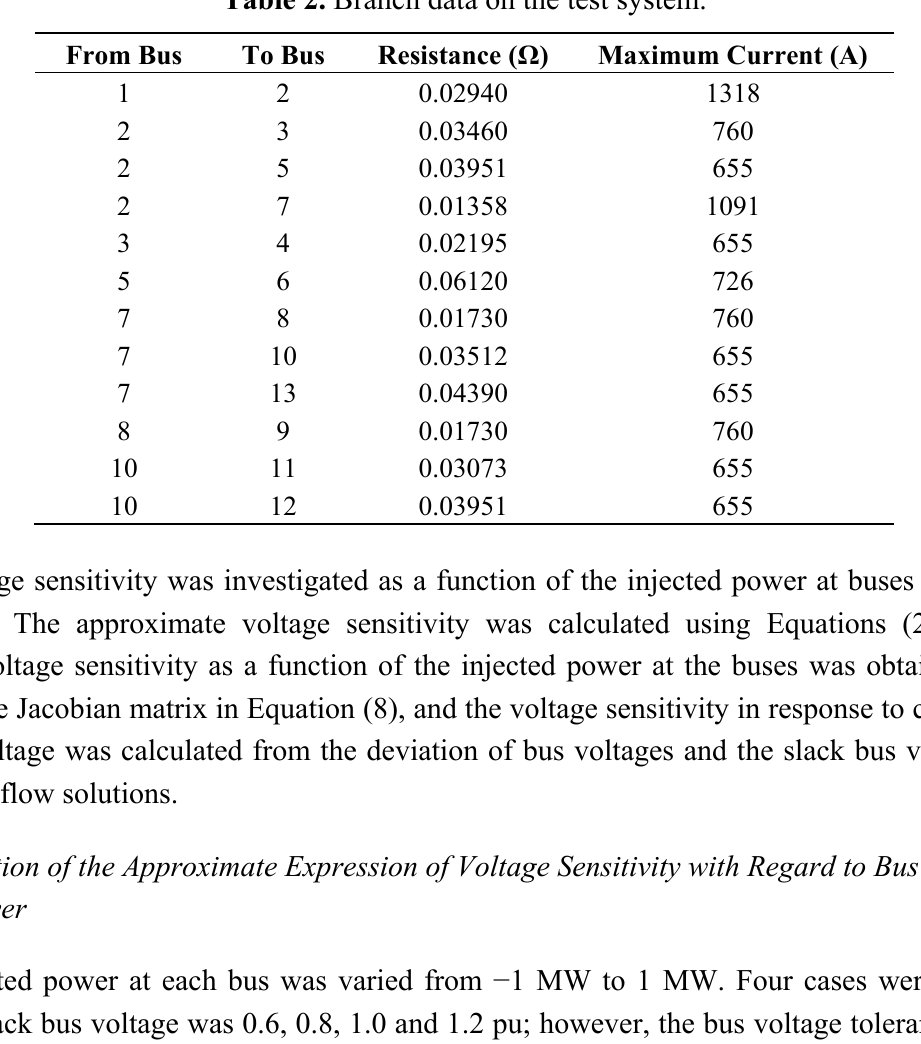
Table 2. Branch data on the test